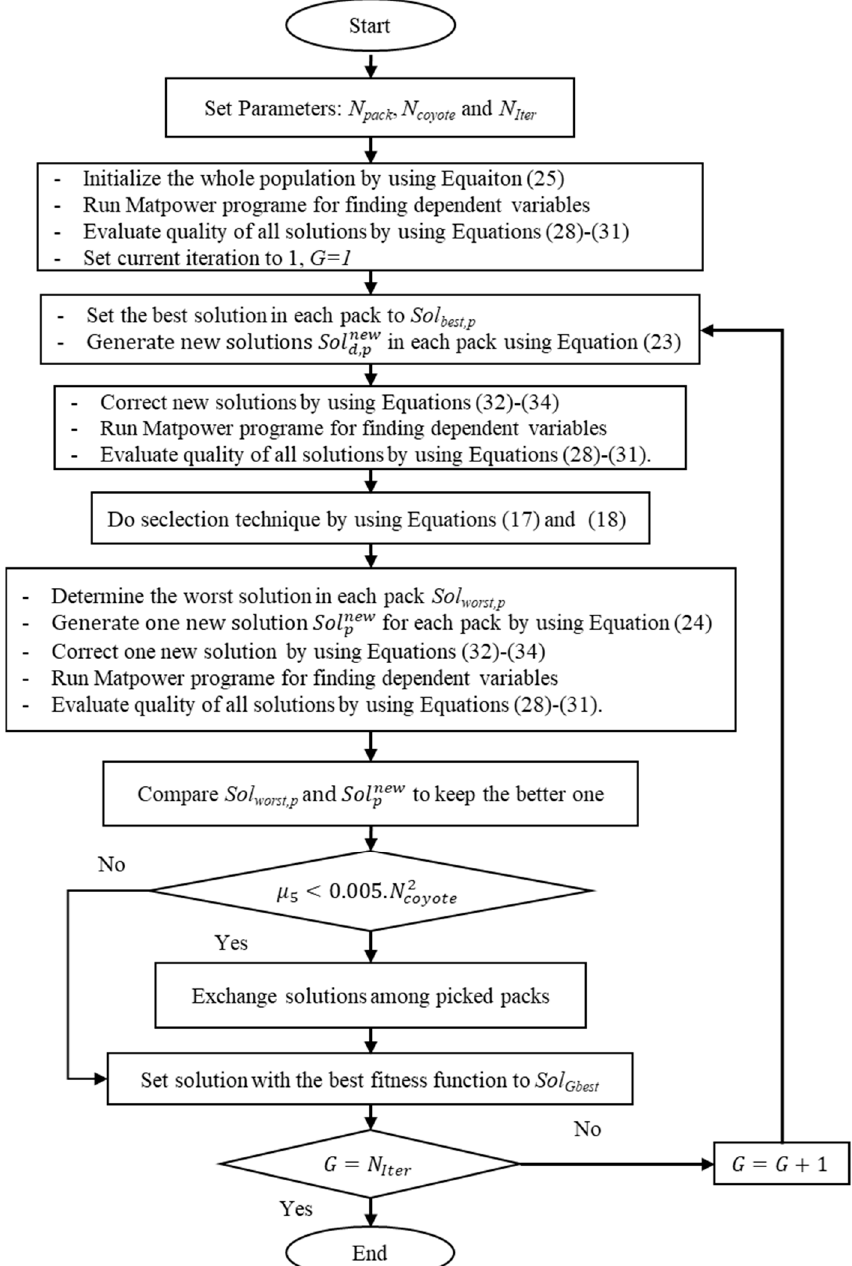
Figure 4. The flowchart of solving the ORPD problem by using the proposed ICOA method.